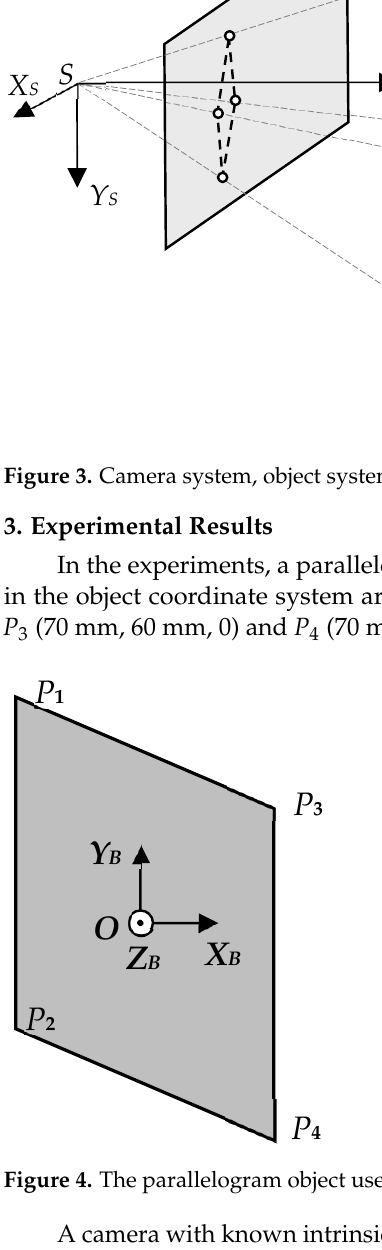
Figure 3. Camera system, object system and the four vertices’ coordinates in the two systems.